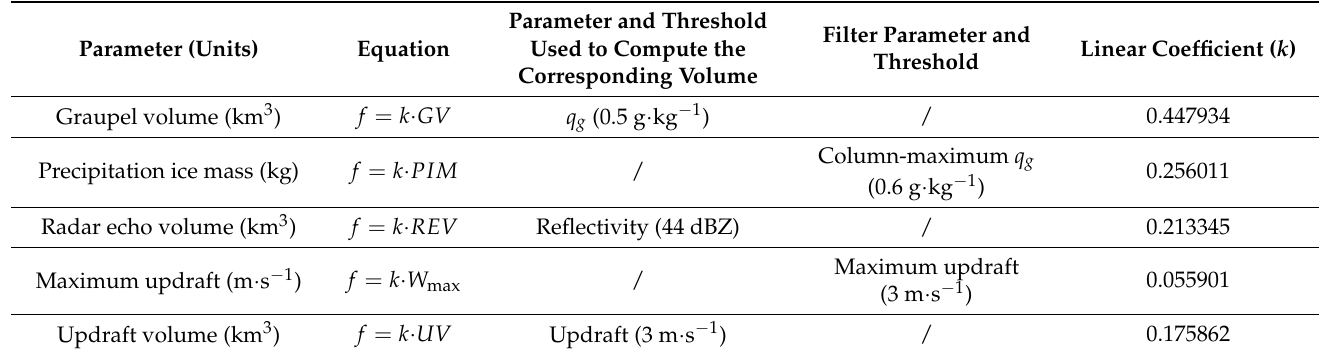
Table 1. Summary of lightning diagnostic schemes with different